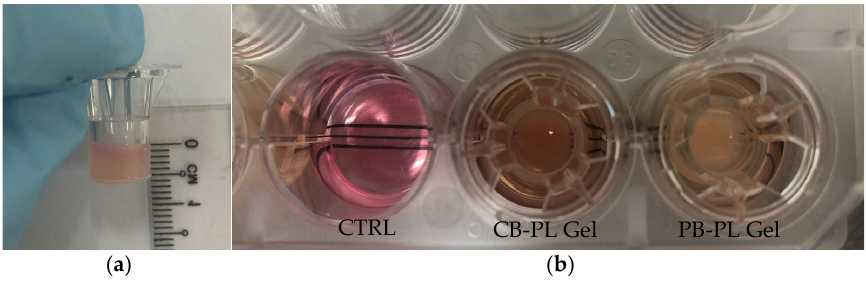
Figure 7. PL gels were formed with the addition of conditioned medium and CaCl 2 in PL. ( a ) PL gel was collected for weight measurement on day 3 of the wound scratch assay and ( b ) PL gel with the culture insert was submerged in the 24-well plate for the wound scratch assay.